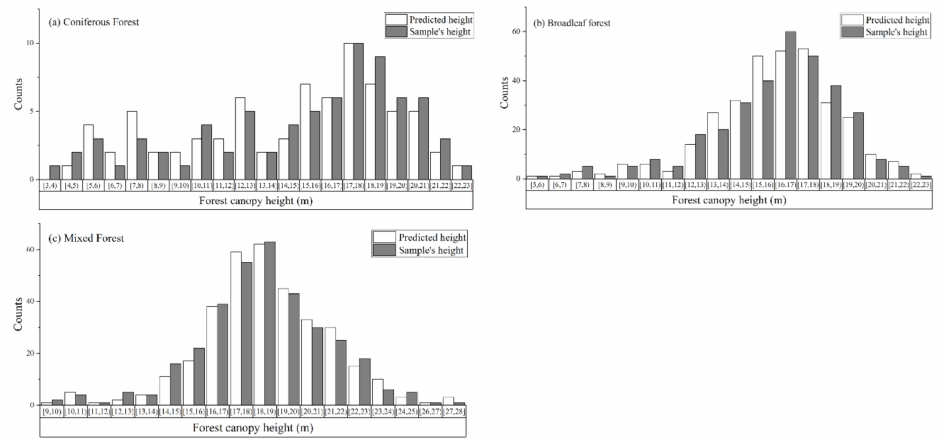
Figure 6. The histograms of predicted canopy heights and RH95 metric of samples in three sub- regions. ( a ) Coniferous forest, ( b ) Broadleaf forest, and ( c ) Mixed